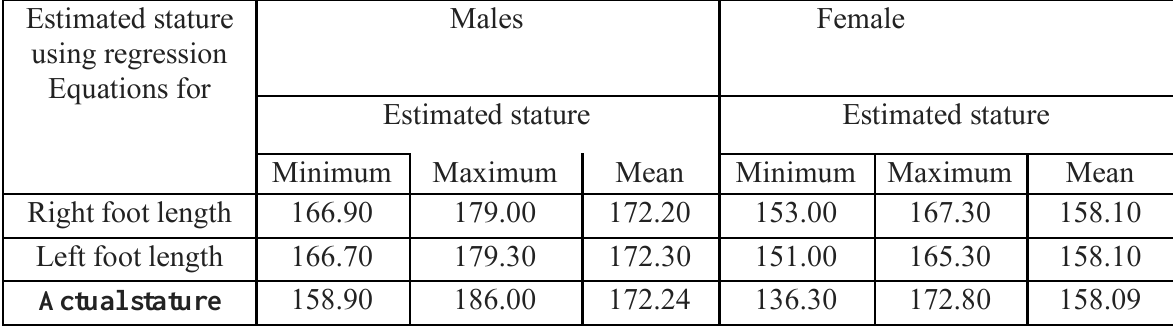
Table 4. Comparison of actual stature and stature estimated (cm) from measurement of